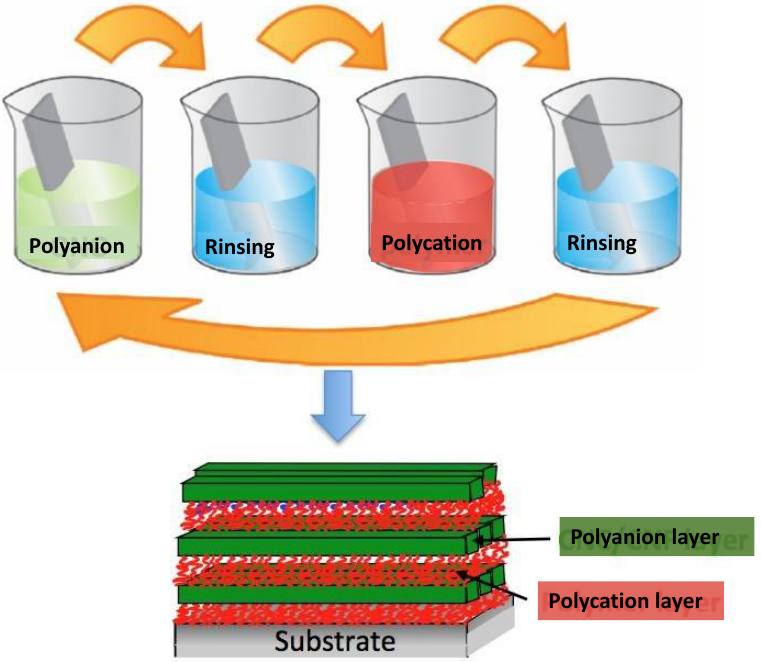
Figure 2. Diagram of the LbL deposition process based on the alternating exposure of a charged substrate to solutions of positively and negatively charged polyelectrolytes.